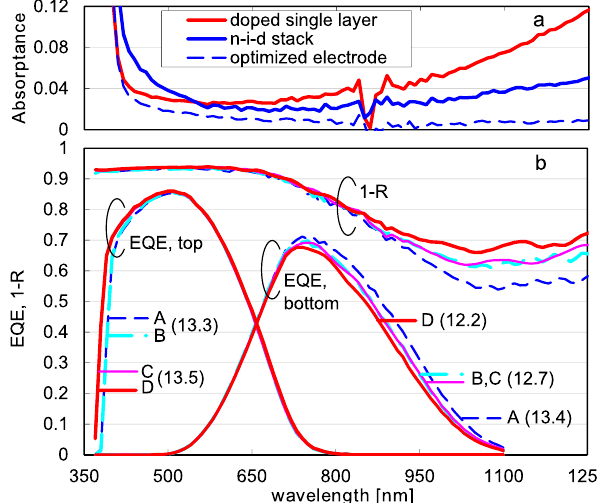
Fig. 2. (a) Absorptance of ZnO front electrodes used in this study as sketched in Figure 1, and of the optimized electrode used in the device of Figure 4. These measurements were made in air with an index-matching liquid (CH 2 I 2 ). (b) EQE and 1-Reflection (1- R ) of the four micromorph devices sketched in Figure 1 having only their ZnO electrodes changed. The number in parenthesis are current density values for the top and bottom cells, in mA/cm 2